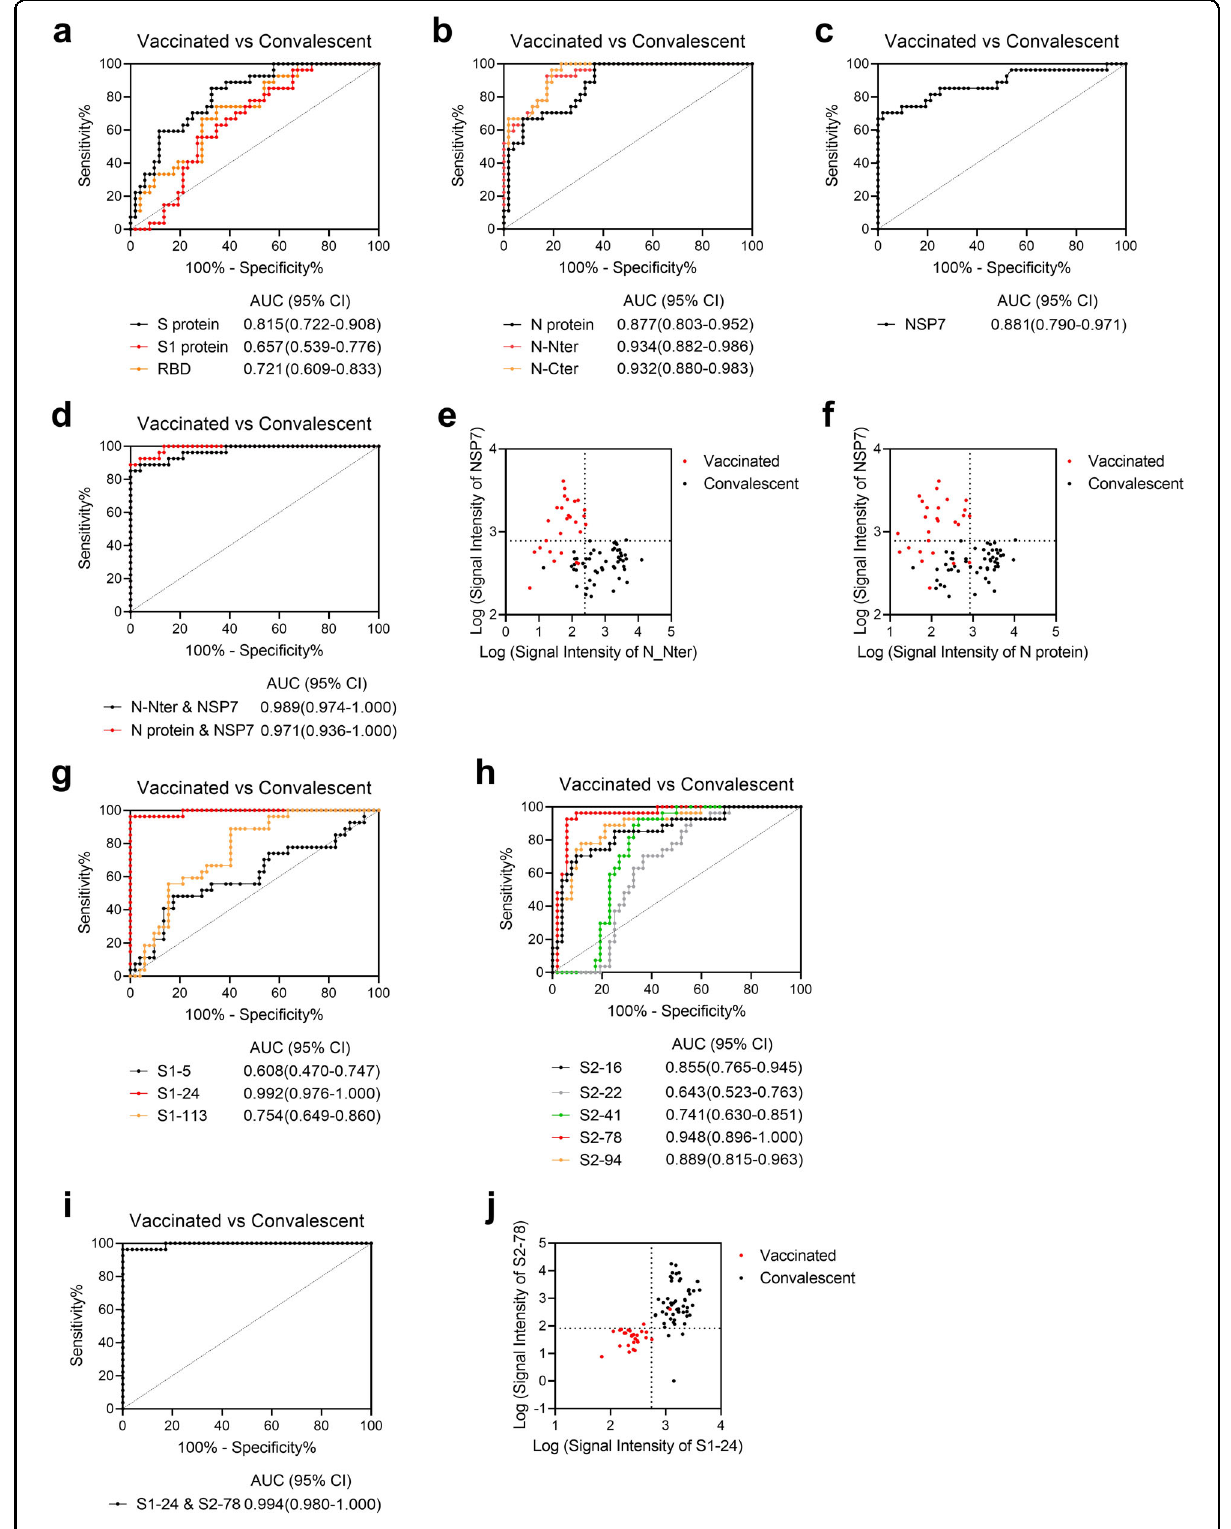
Fig. 5 (See legend on next